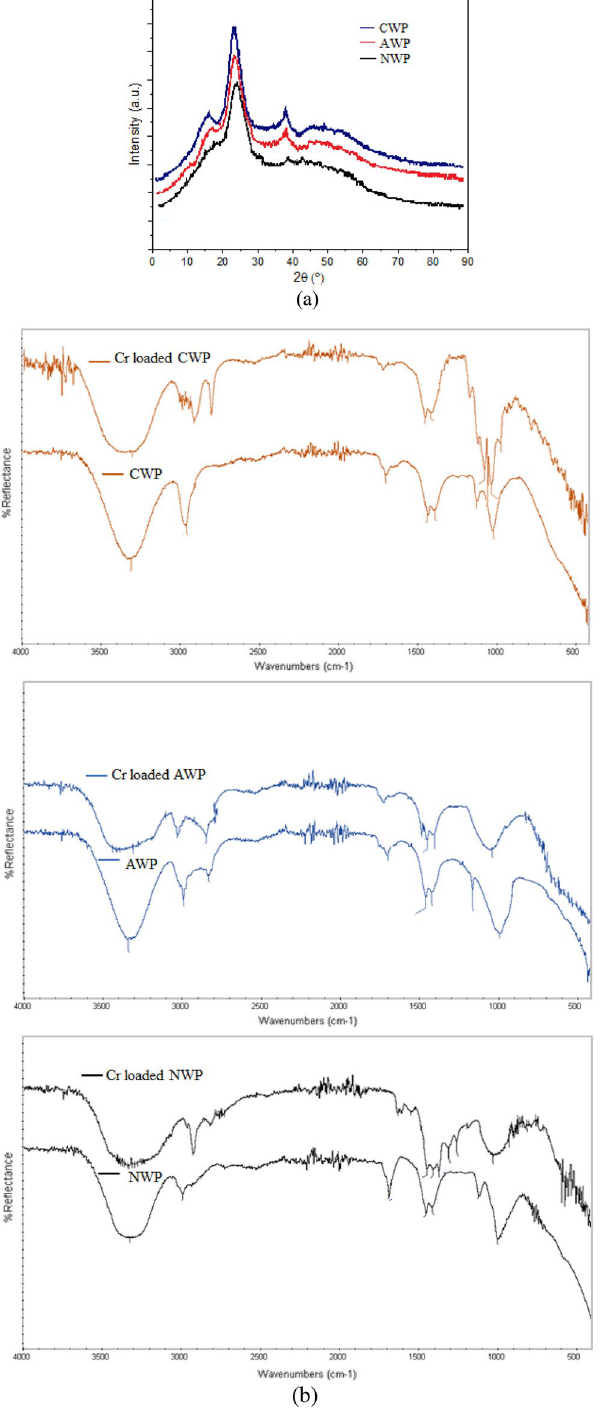
Figure 3. ( a ) XRD of native biosorbents ( b ) FTIR spectra of native and Cr-loaded